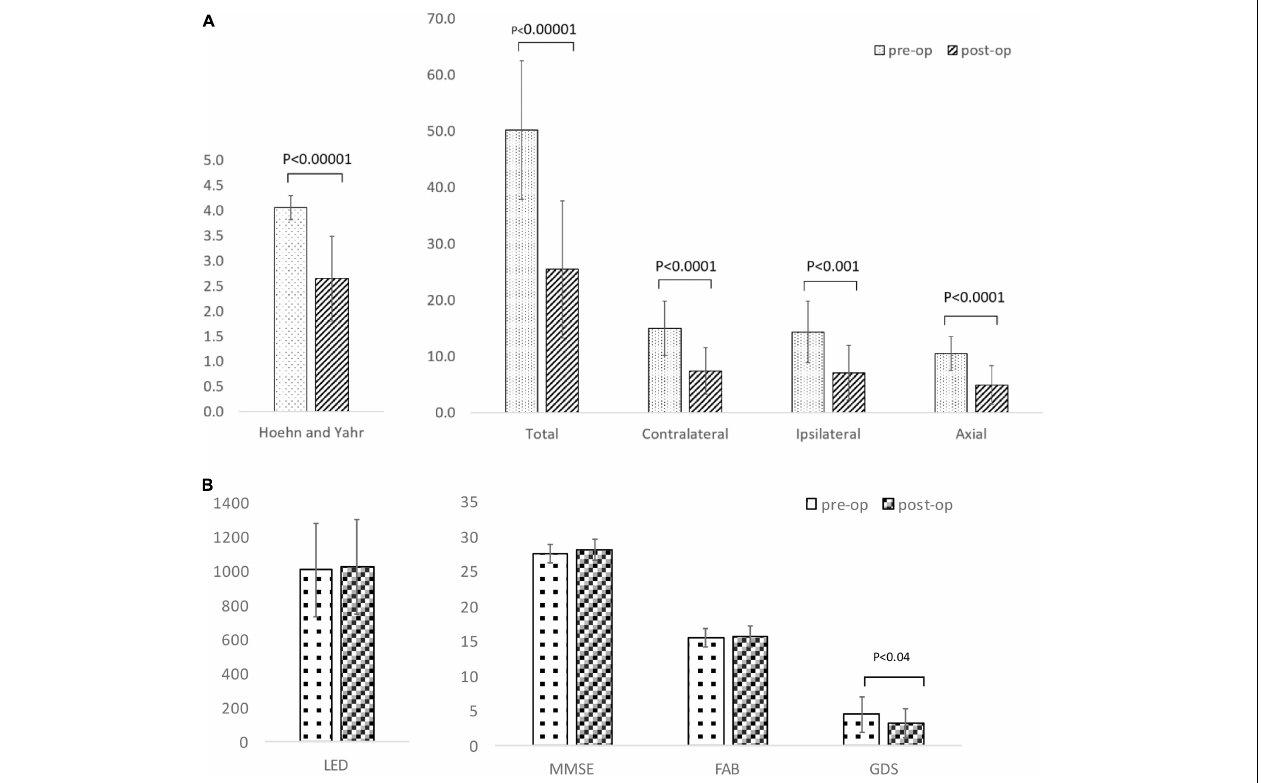
FIGURE 3 | (A) Comparison of Movement Disorder Society-Unified Parkinson’s Disease Rating Scale (MDS-UPDRS) motor scores and Hoehn and Yahr stage between baseline and after unilateral deep brain stimulation of the globus pallidus internus (GPi-DBS). (B) Comparison of levodopa equivalent dose (LED), Mini-Mental State Examination (MMSE), Frontal Assessment Battery (FAB), Geriatric depression scale (GDS) between baseline and after unilateral deep brain stimulation of globus pallidus internus